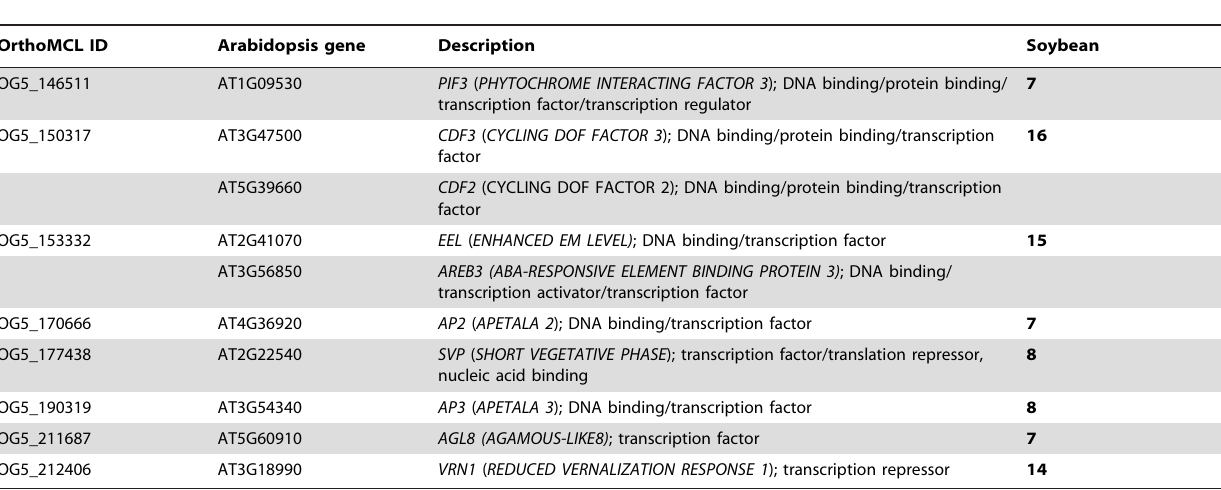
Table 2. List of paralogue-rich OGs containing Arabidopsis flowering genes.